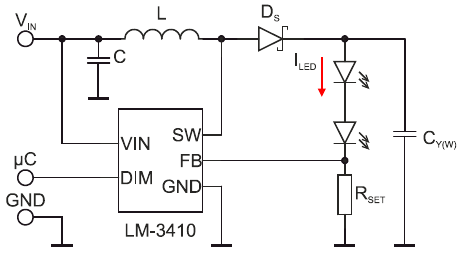
Figure 9. LED driver schematics (adapted from [43]).